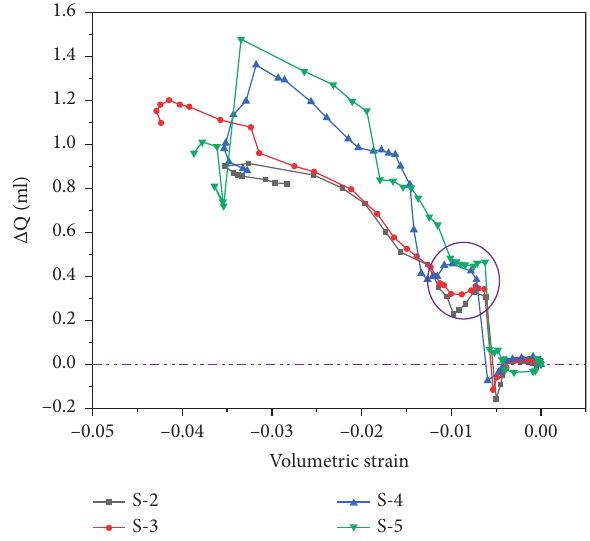
Figure 8: Curves demonstrating the relationship between sand- stone seepage unloading and